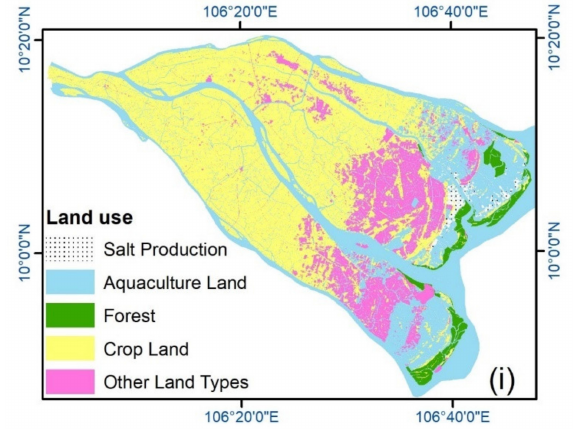
Figure 3. Thematic maps for DRASTIC and Mod-DRASTIC models (i.e., ( a ) depth of water, ( b ) net recharge, ( c ) aquifer media, ( d ) soil media, ( e ) slope, ( f ) vadose zone materials, ( g ) hydraulic conductivity, ( h ) river catchment, and ( i ) land